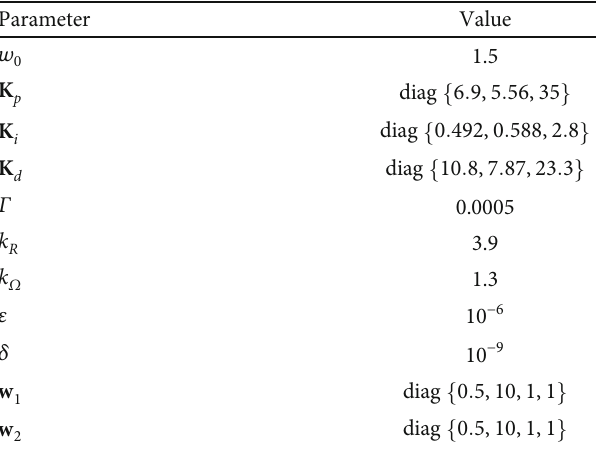
Table 2: Parameters in controller and control command allocation algorithm.